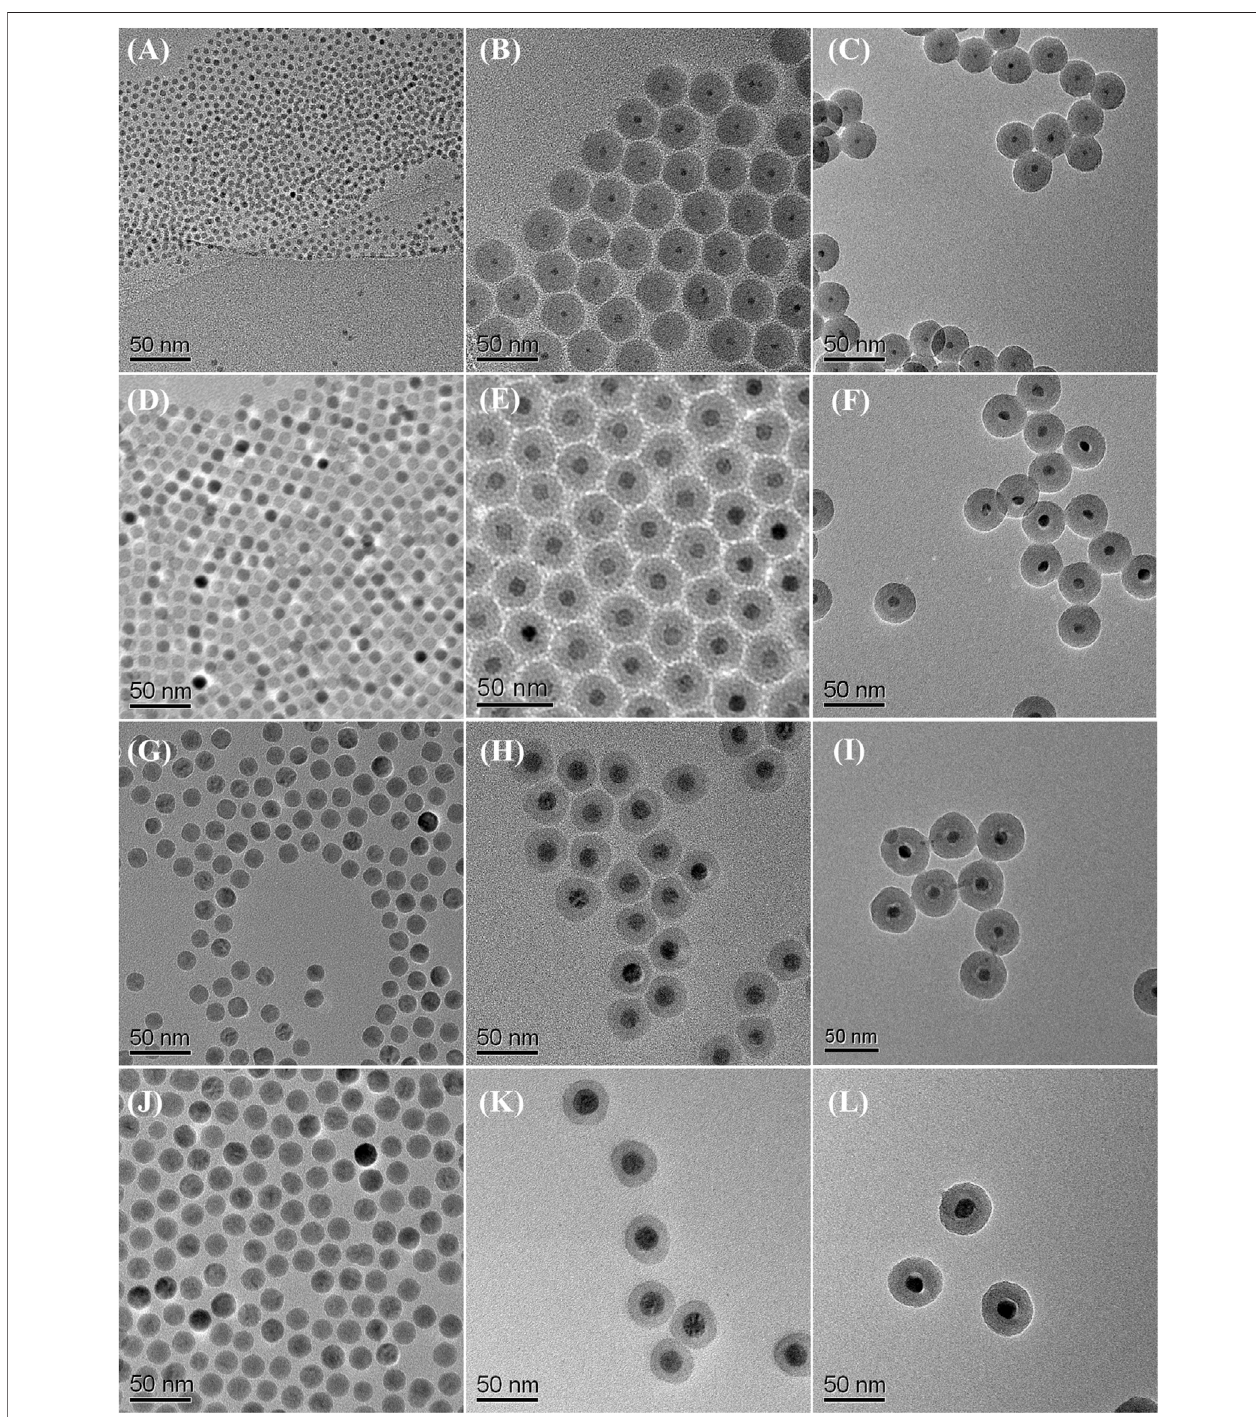
FIGURE 2 | TEM images of starting iron oxide nanoparticles of (A) 6.1 nm (D) 10.3 nm (G) 16.2 nm, and (J) 21.8 nm; iron oxide at silica core/shell nanoparticles with (B) 6.1 nm (E) 10.3 nm (H) 16.2 nm,and (K) 21.8 nmcore (C) ironnitrideatsilicacore/shellnanoparticlestransferredfrom (B)(F) nanoparticlestransferredfrom (E) (I) nanoparticles transferred from (H) , and (L) nanoparticles transferred from (K) .